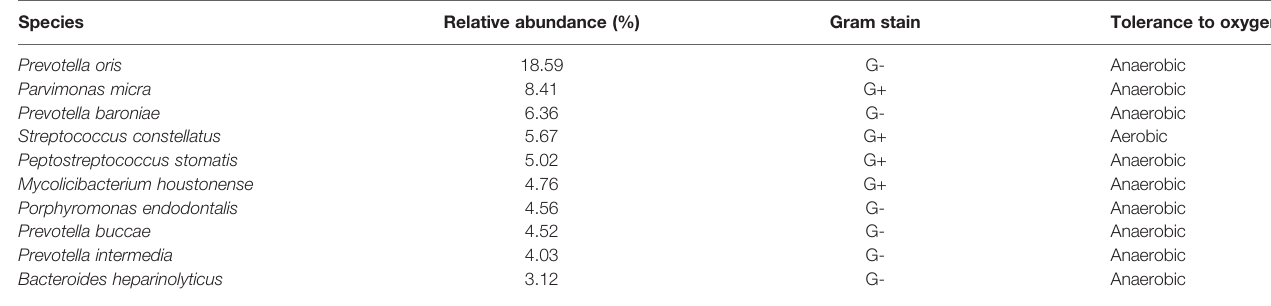
TABLE 3 | Top 10 species detected in MI group. Species